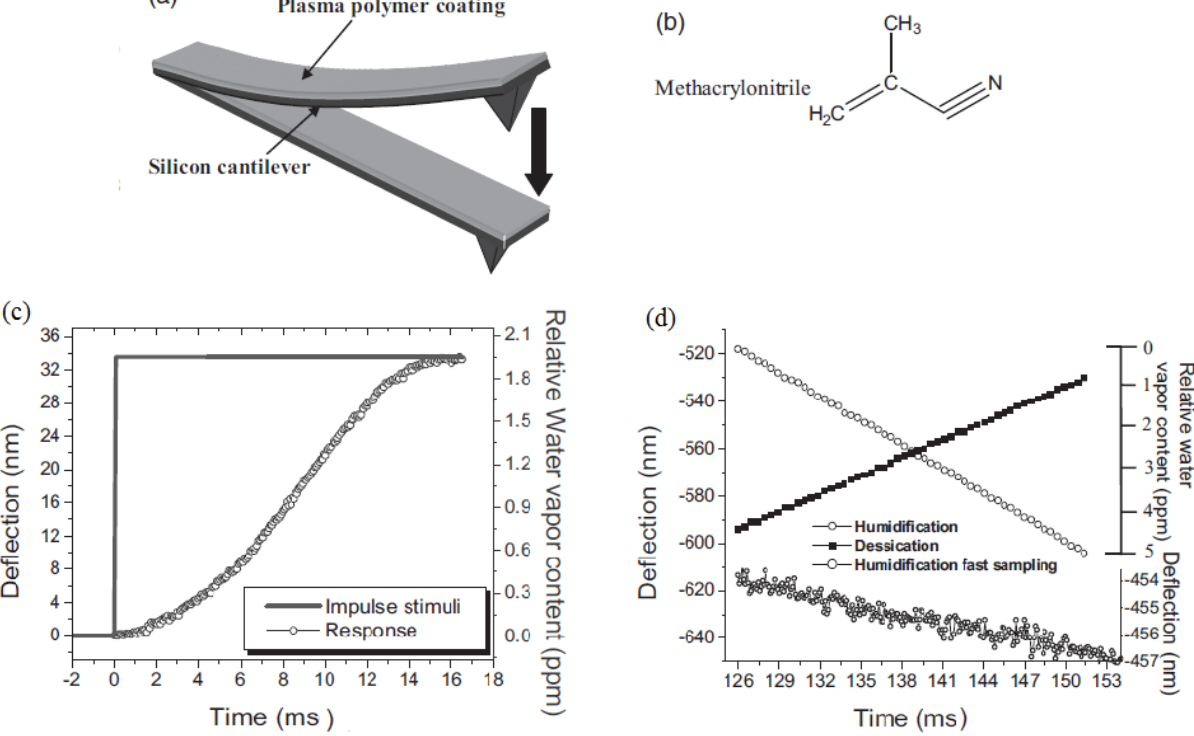
Figure 8. ( a ) Simplified diagram of the functionalization of the silicon cantilever coated with polymer; ( b ) Chemical structure of methacrylonitrile; ( c ) Deflection of cantilever in response to sudden humidity change and ( d ) Dynamic sampling during linear humidification and desiccation (reprinted with permission